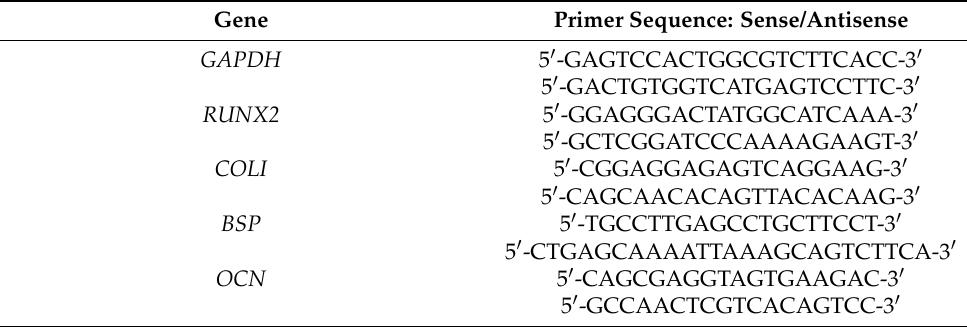
Table 1. Oligonucleotide primer for PCR amplification.